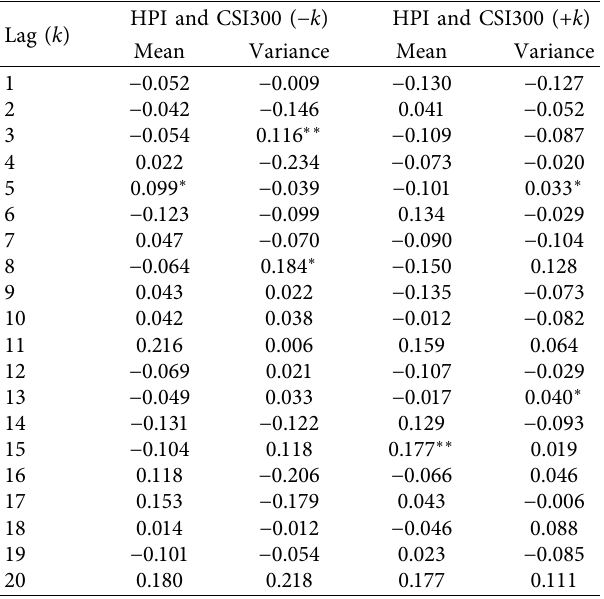
Table 3: Results of cross-correlation